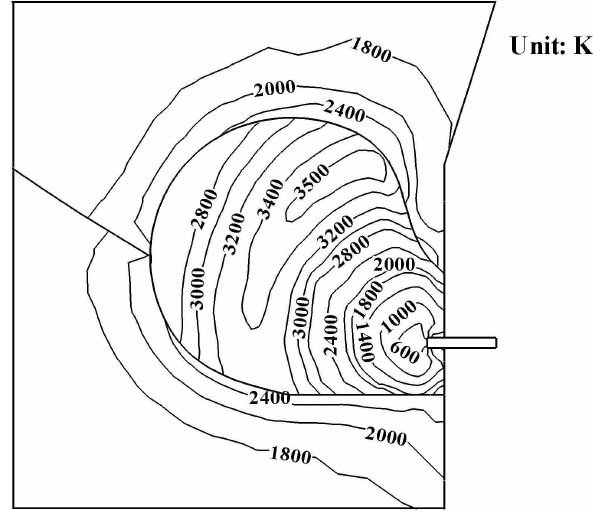
Figure 3: Gas phase temperature distribution around